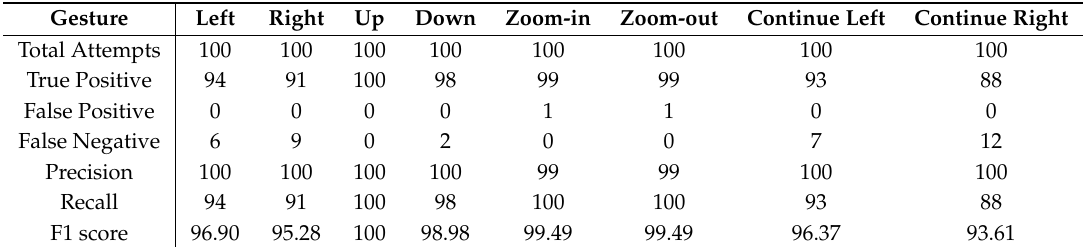
Table 2. Experiment results of precision error, recall error, and F1 score about each gesture of 10 subjects at 50–60 cm.